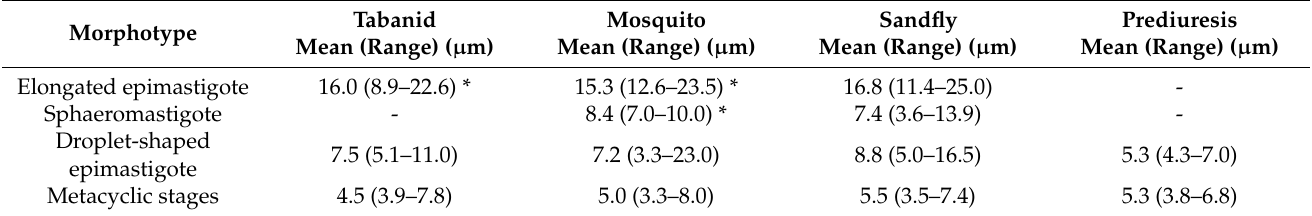
Table 3. Summary table of the measured length of T. theileri